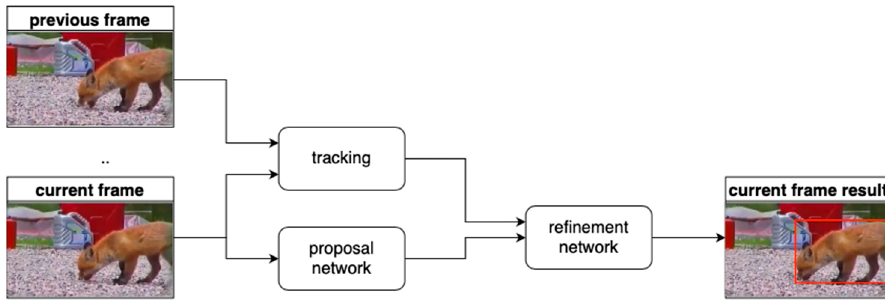
Figure 8. CaTDet framework [78].